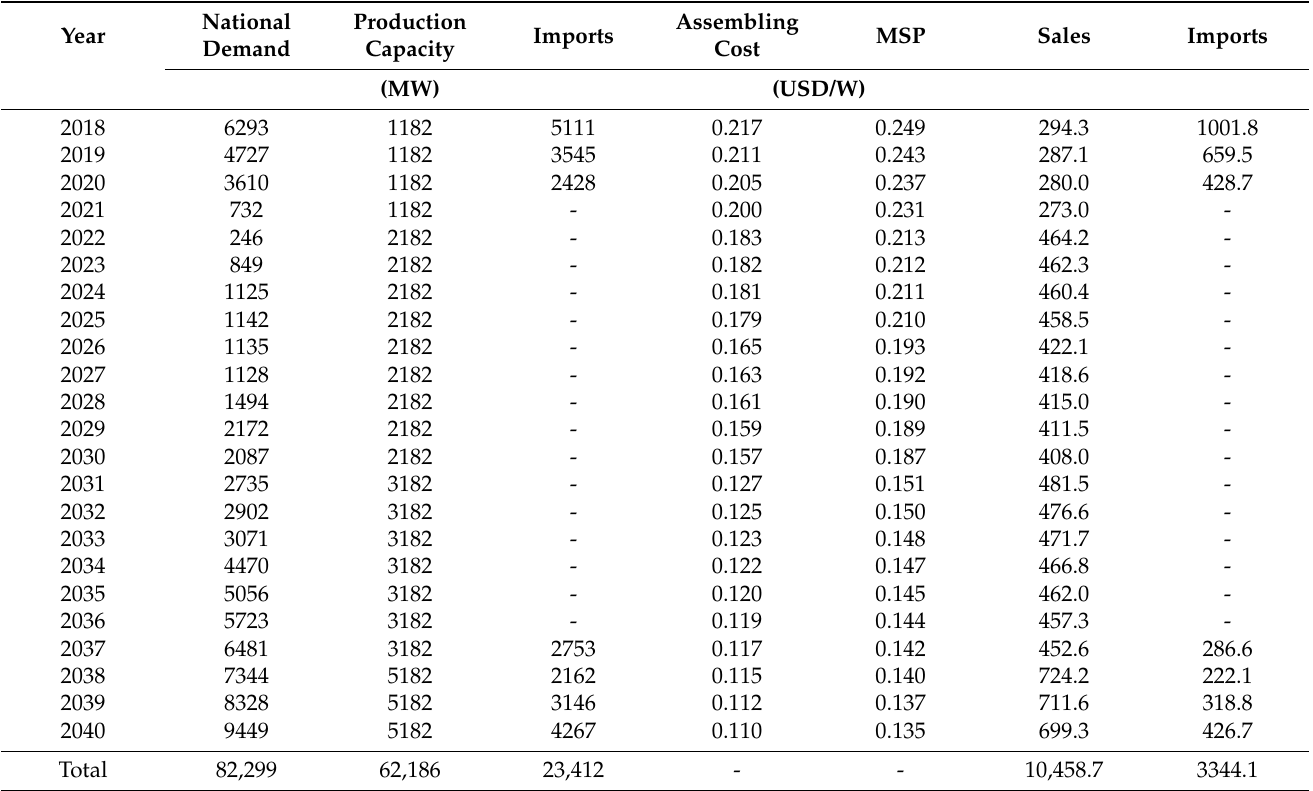
Table 10. Evolution of the VCPVIM production capacity, costs, and prices in the Alternative